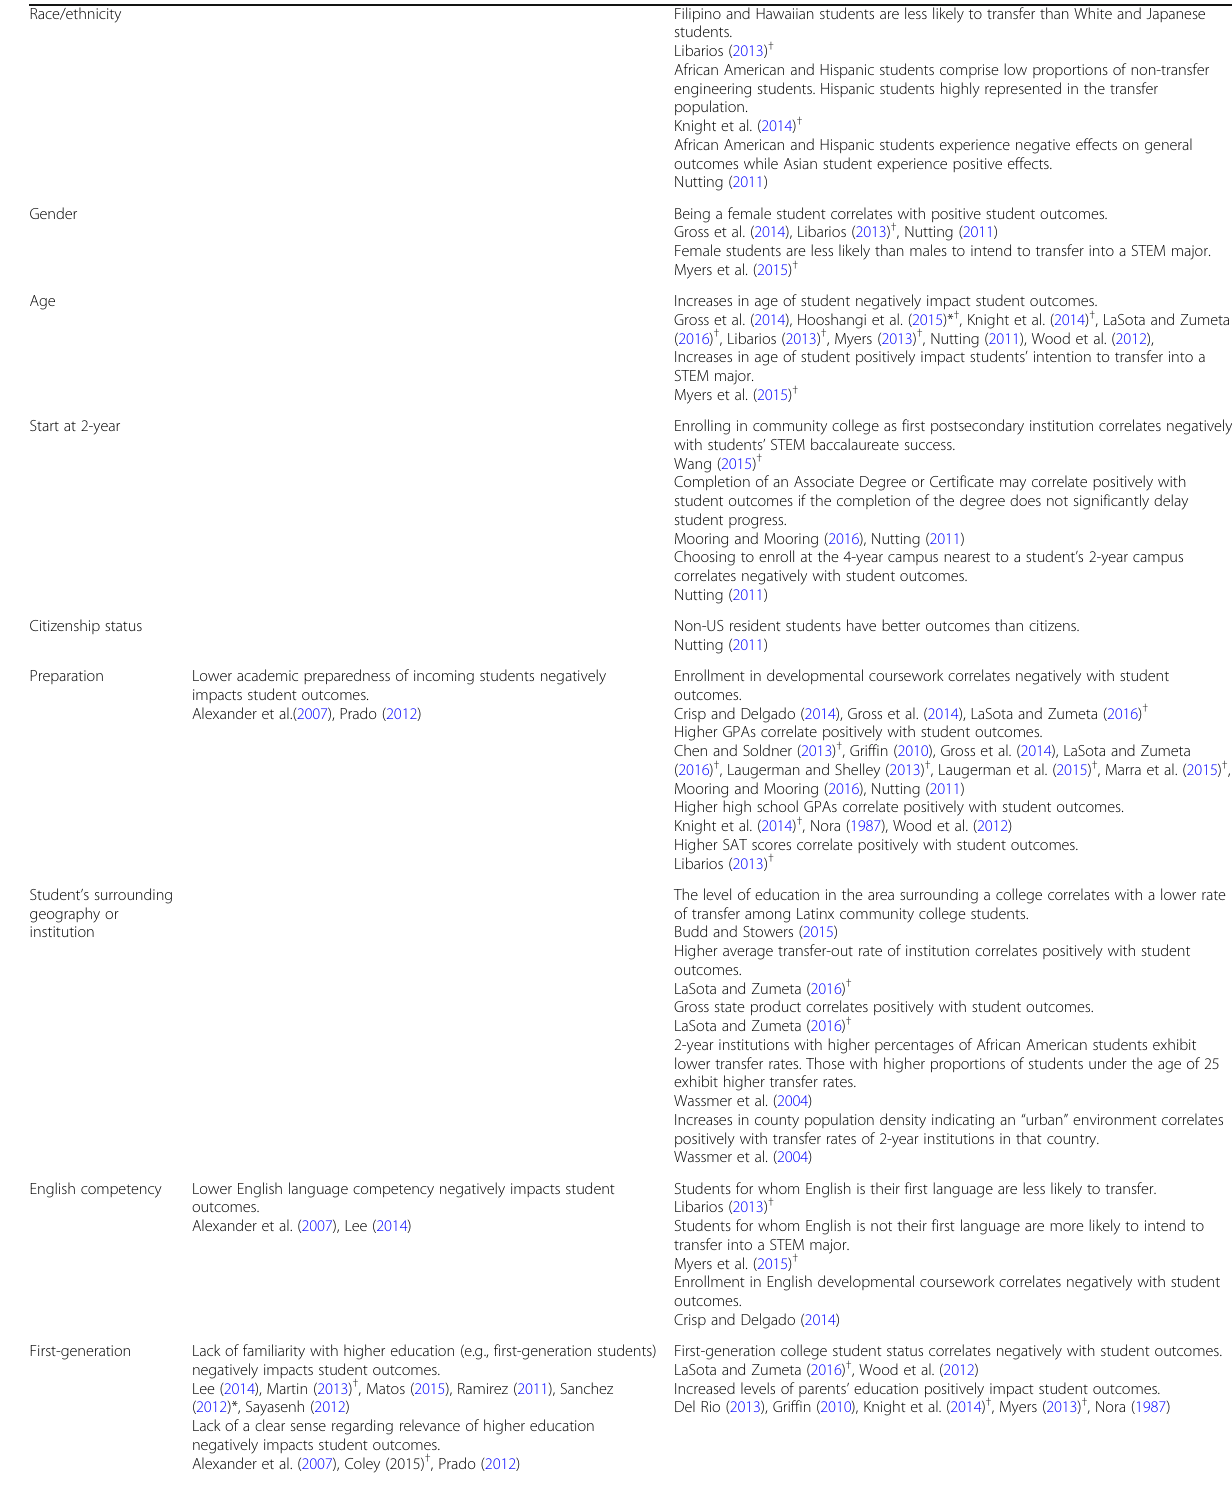
Table 5 Findings on characteristics of students, their families, and their communities